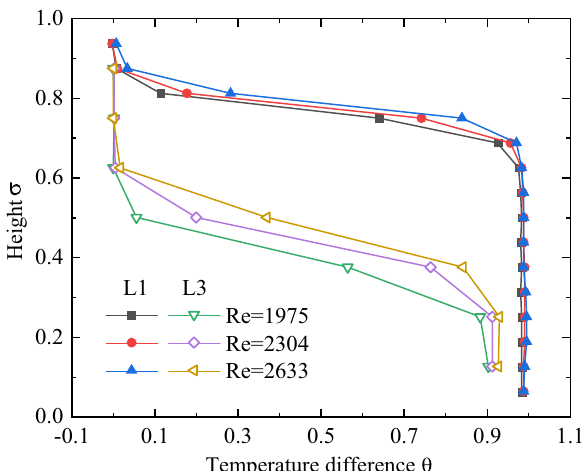
Fig. 11 Temperature changes of L1 and L3 in backward flow mode when Fo is